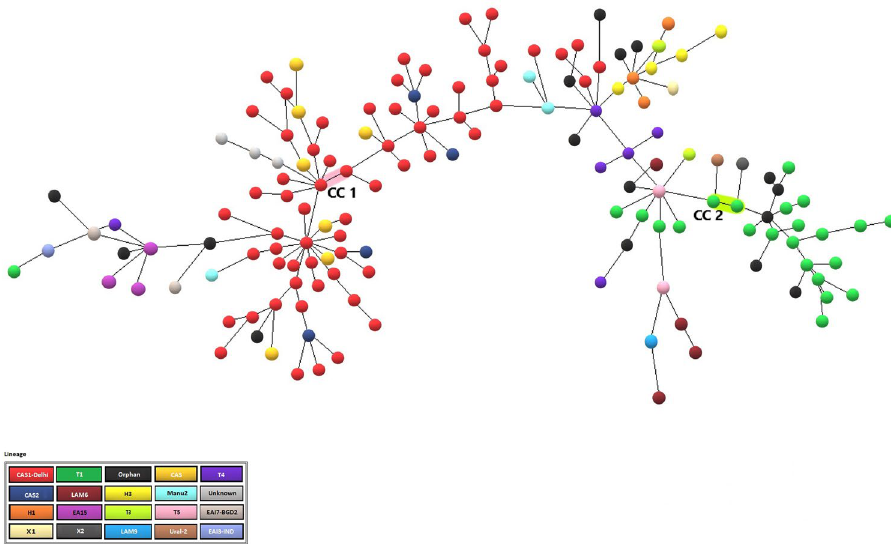
Figure 4. The Minimum Spanning Tree (MST) of 150 Non-Beijing isolates from Sikkim, India. Only two Clonal Complexes (CC1 & CC2) are present. The most dominant lineage among non-Beijing isolates was CAS1-Delhi represented by red dots in the MST. 17 orphan/new MTBC isolates discovered in the study are represented by black dots. This MST was developed using the MIRU-VNTRplus web tool (https:// www. miru- vntrp lus. org), and the figure was enhanced using Microsoft Paint (https:// ms- paint. en. softo nic. com/).